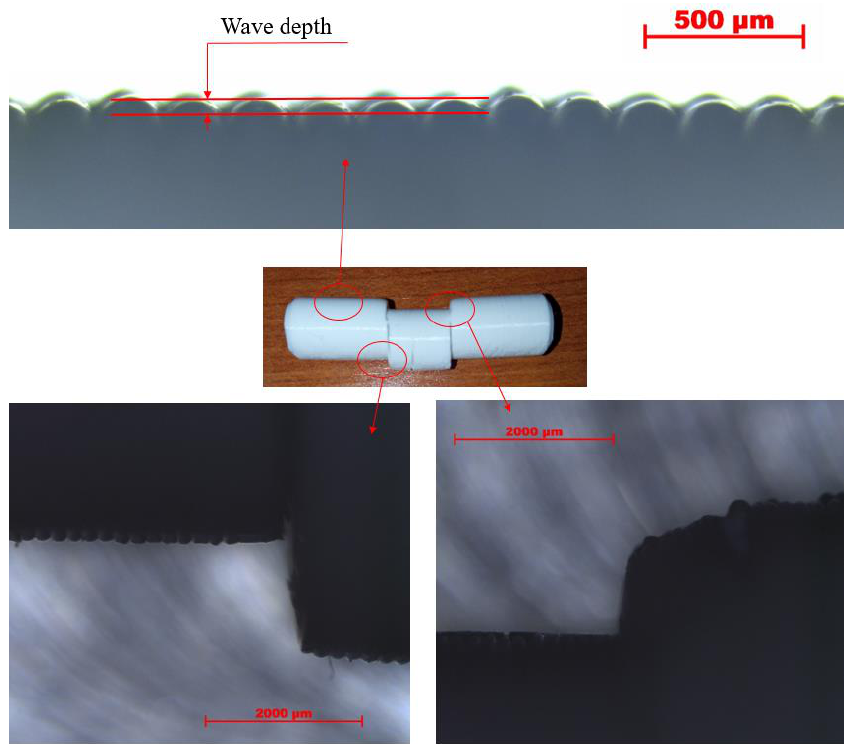
Figure 4. Representation of the flattening of the wavy surfaces.